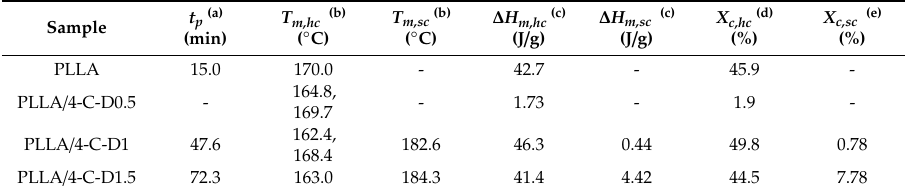
Figure 5. Isothermal ( a ) and heating ( b ) DSC curves of PLLA and PLLA / 4-C-D blends with PDLA block lengths. Table 2. Characteristic values of isothermal crystallization and subsequential heating process of PLLA and its blends with di ff erent PDLA block